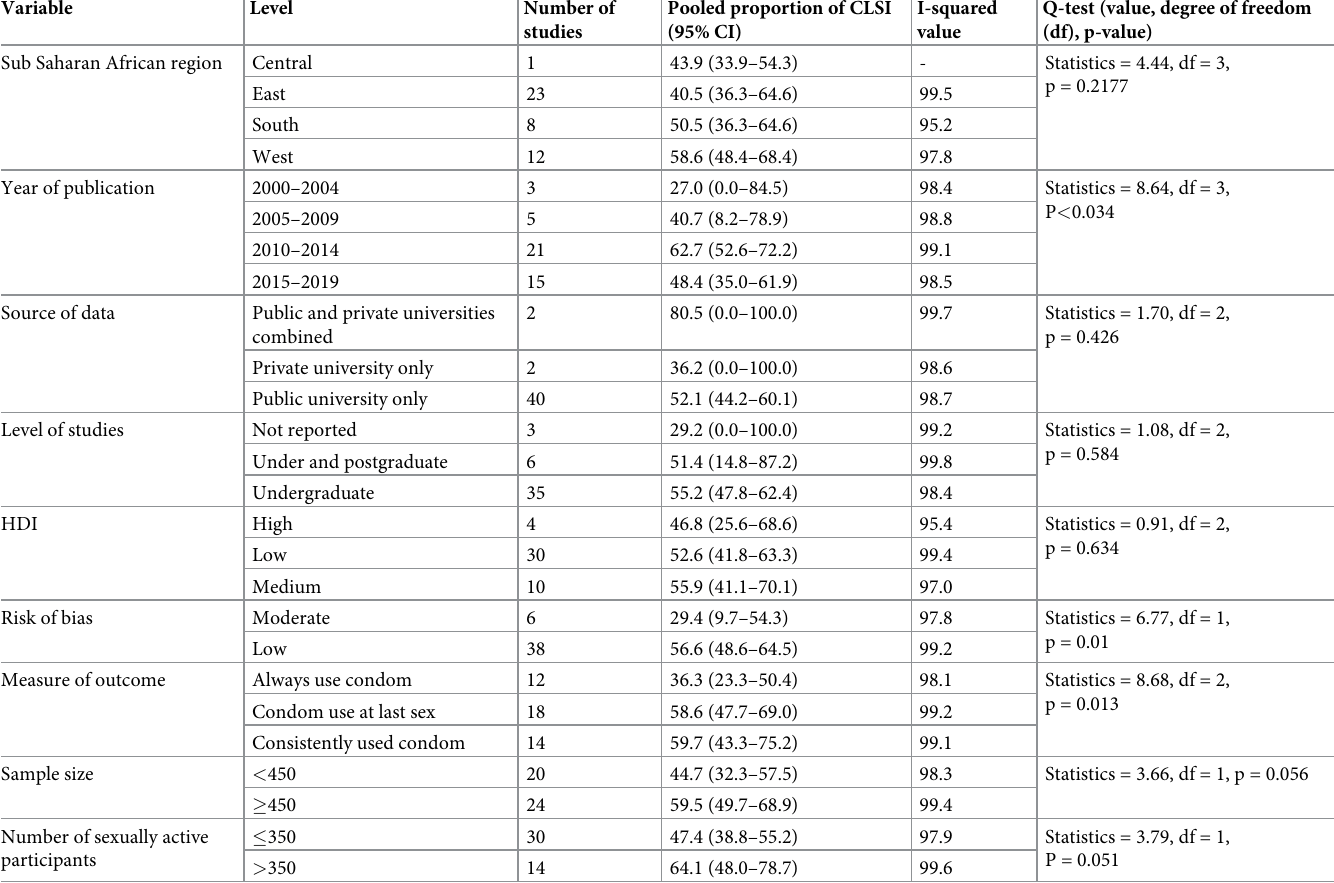
Table 2. Sub-group analysis and sources of heterogeneity in included